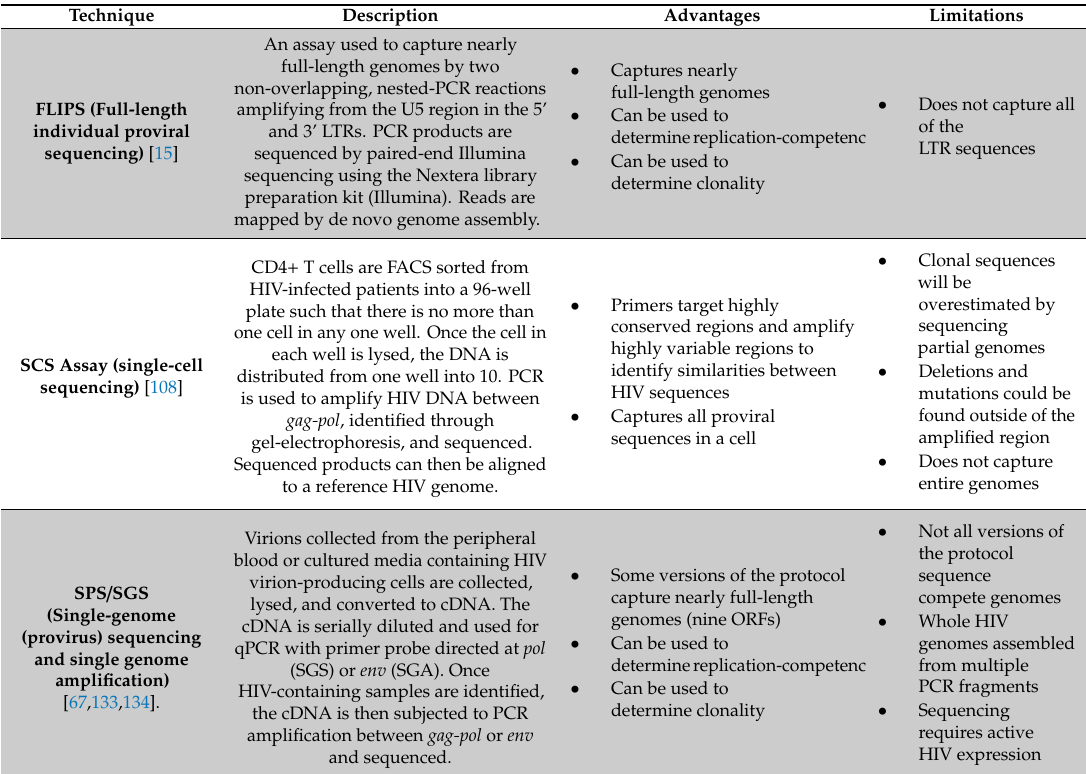
Table 2. Genome Amplification and Sequencing.